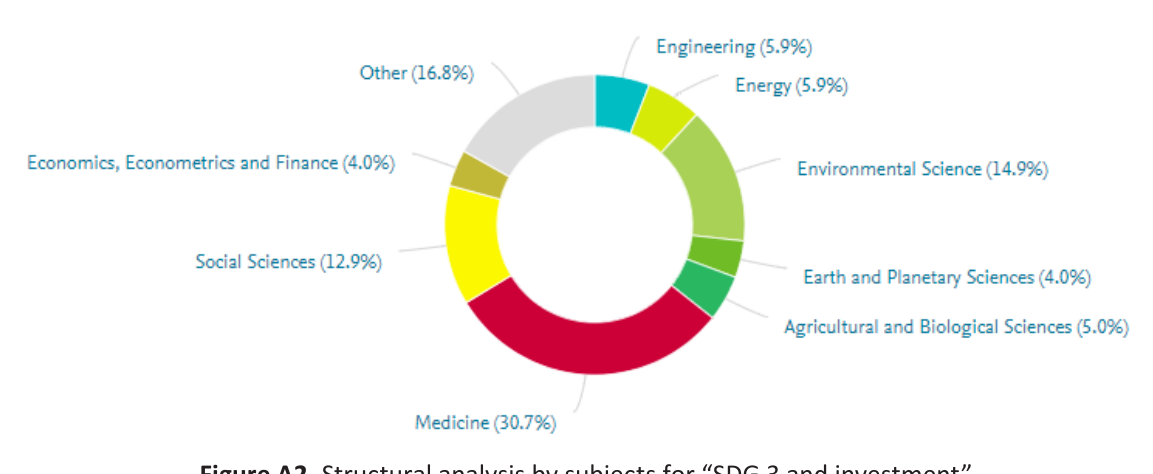
Figure A2. Structural analysis by subjects for “SDG 3 and investment”